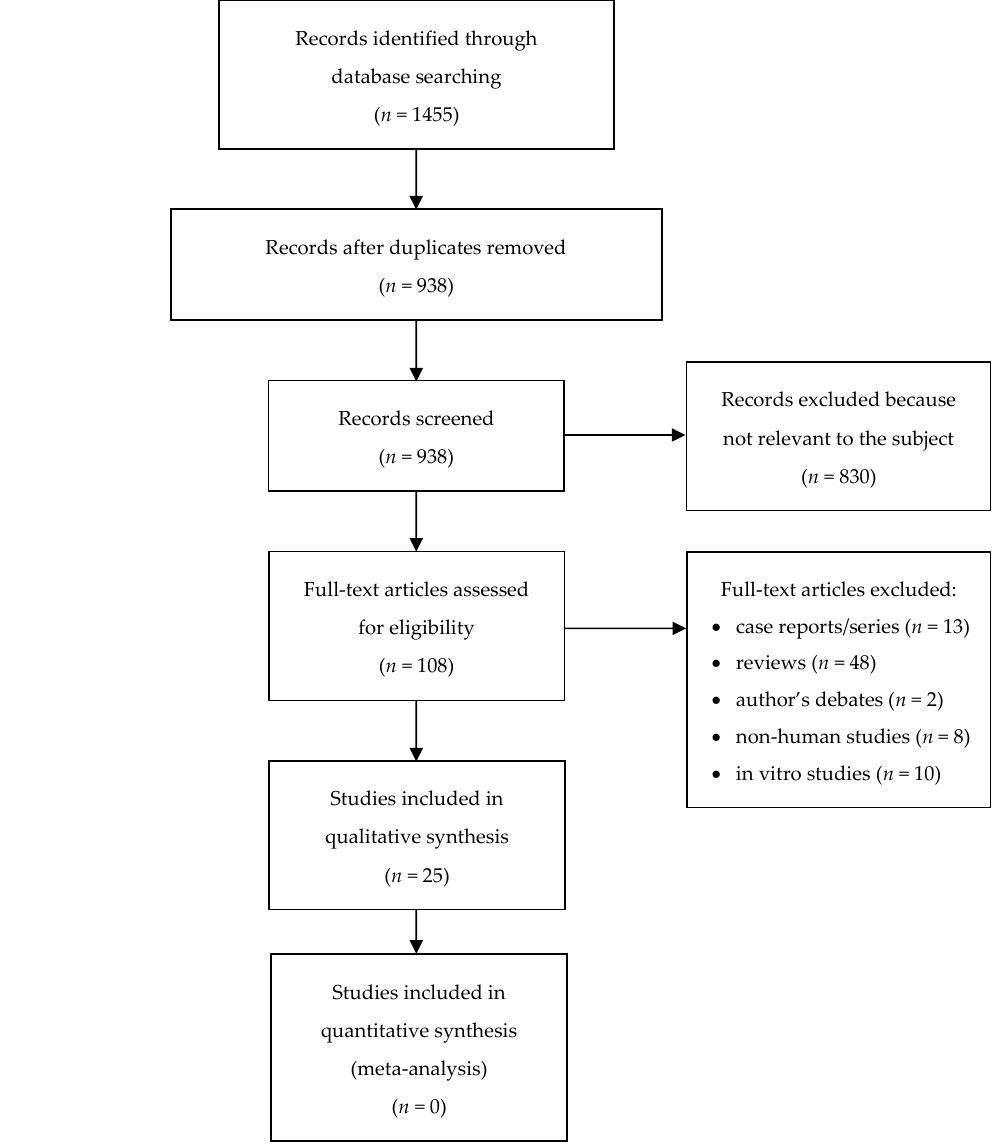
Figure 1. PRISMA flow diagram of literature search.